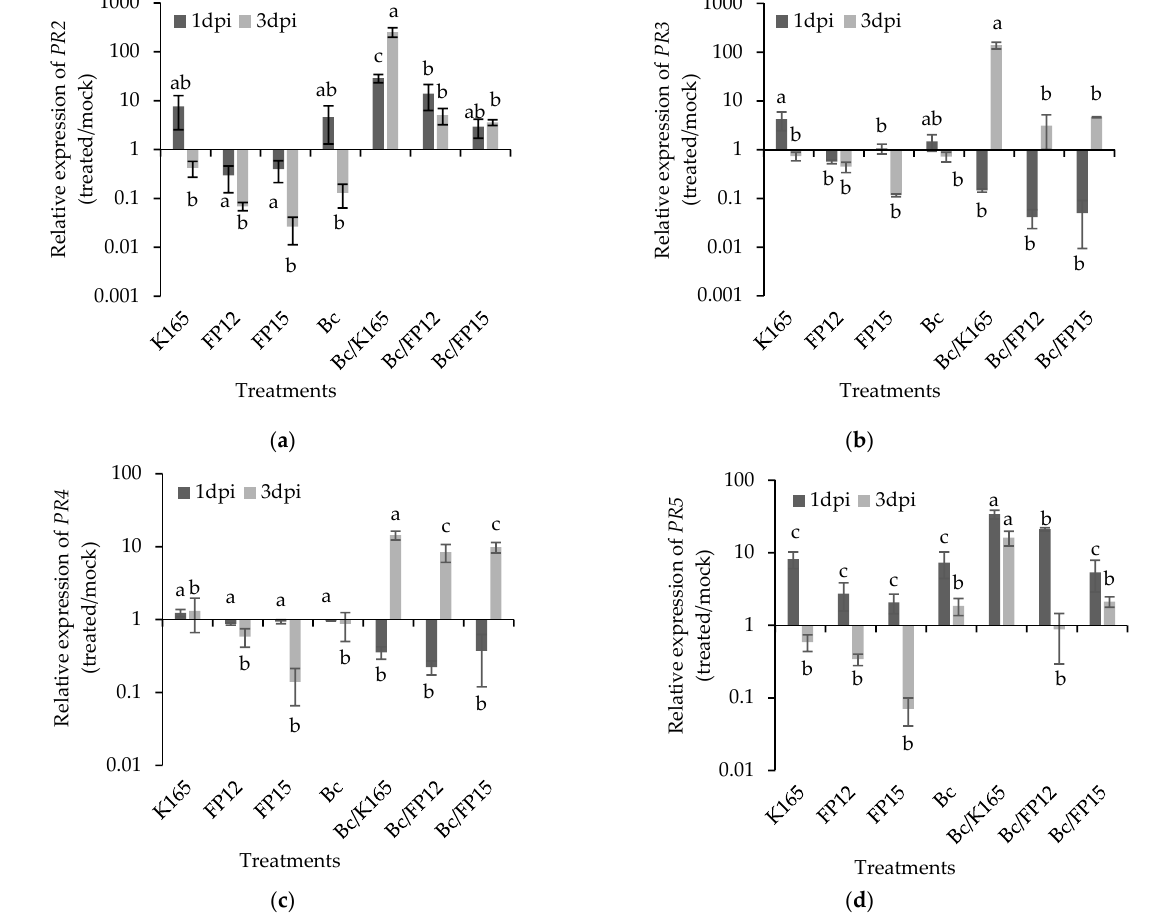
Figure 4. Relative transcript levels of PR2 ( a ), PR3 ( b ), PR4 ( c ) and PR5 ( d ) in the pericarp of grape berries treated with